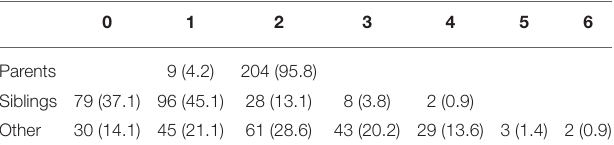
TABLE 2 | Number of people [ N (%)] specified in the questionnaire for language use with the